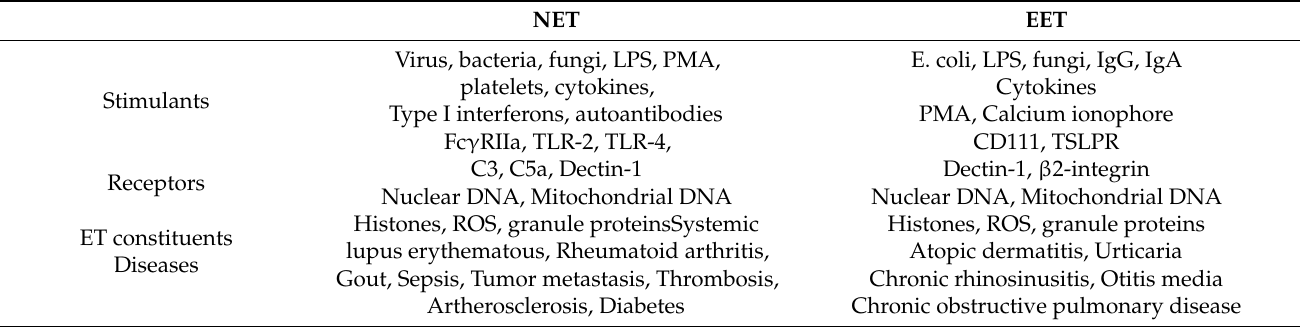
Table 1. Immunopatholoic characteristics of neutrophil extracellular trap (NET) and eosinophil extracellular trap